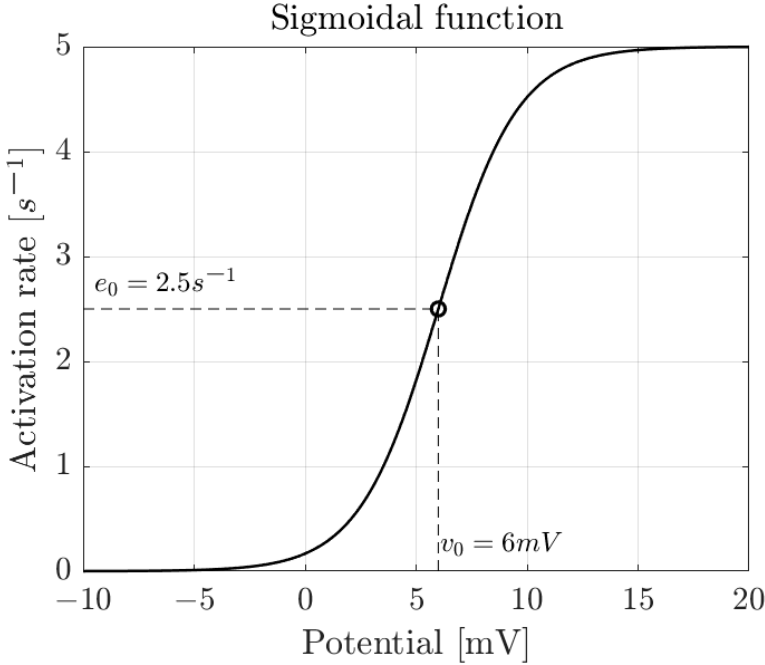
Figure 2. Sigmoidal function changing the population’s membrane potential into fluctuation rate.